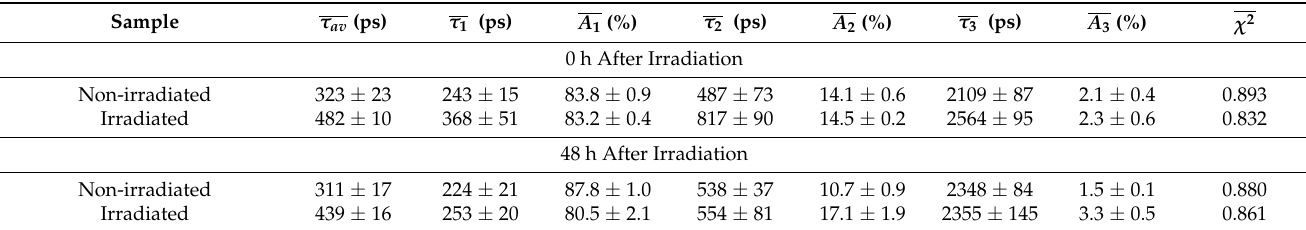
Table 1. Results of the analysis of FLIM images of lipofuscin-granule-fed ARPE-19 cells with and without photo-oxidation under white light irradiation. Results were obtained by the analysis of N = 3 different independent experiments. Data correspond to mean values; errors represent standard deviations. Excitation λ exc: 473 nm; detection λ det: 485 (long pass)